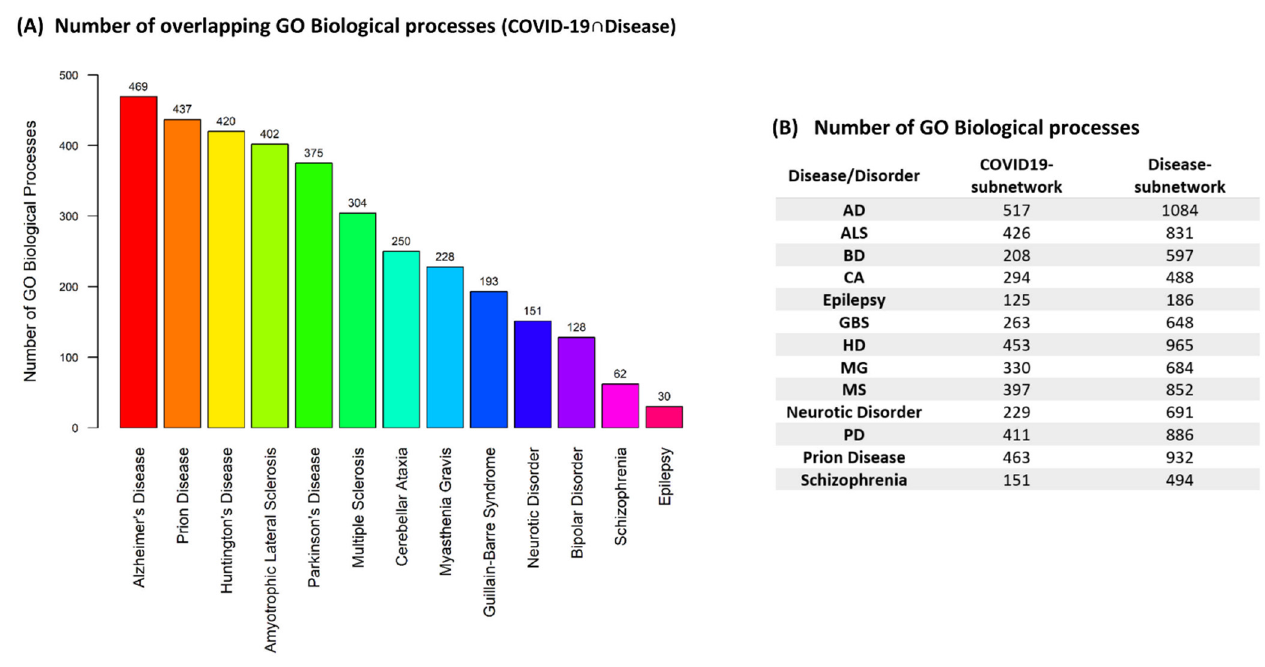
Figure 3. Effects of SARS-CoV-2, via virus–host PPIs, in Neurological Diseases and Neuropsychi- atric Disorders . ( A ) Number of overlapping GO biological processes (COVID-19 ∩ Disease) between COVID-19 and each disease/disorder. ( B ) Number of GO biological processes found to be associ- ated with the extracted subnetworks from each of the thirteen integrated COVID-19-host-disease PPI networks .